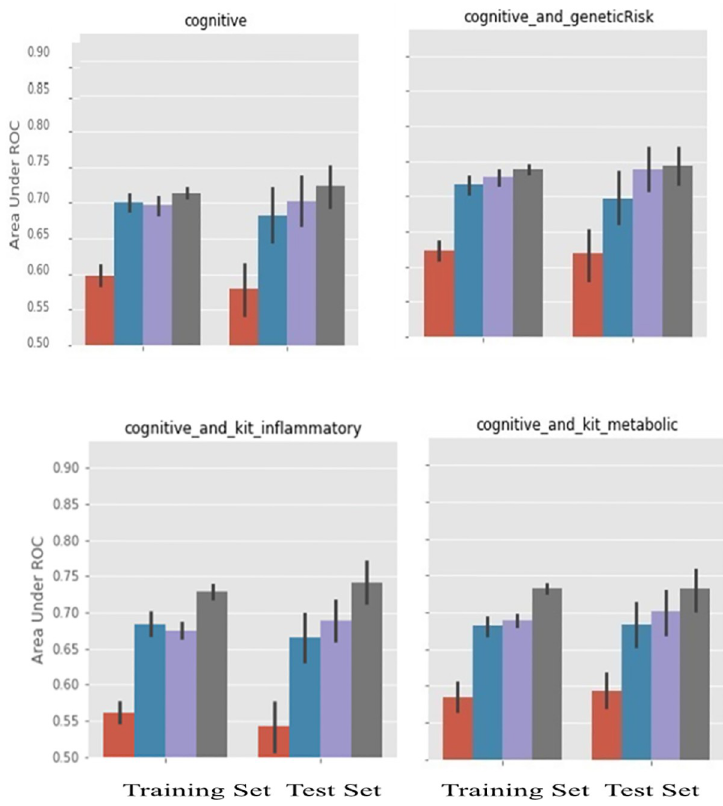
Fig 3. Further comparison of AUC for feature groups focused on non-invasive, easily acquired modalities. As in Fig 2, for all panels, left bars were training AUC results and right bars were test AUC results, the latter being used in our interpretations. The 4 bars show mean AUC as a function of ML technique (left to right, CART, GB, RF, and SVM; same color scheme as Fig 2). Cognitive features used in all panels. Top right also includes genetic risk. Bottom two panels also include plasma biomarker kits (inflammatory (L), metabolic